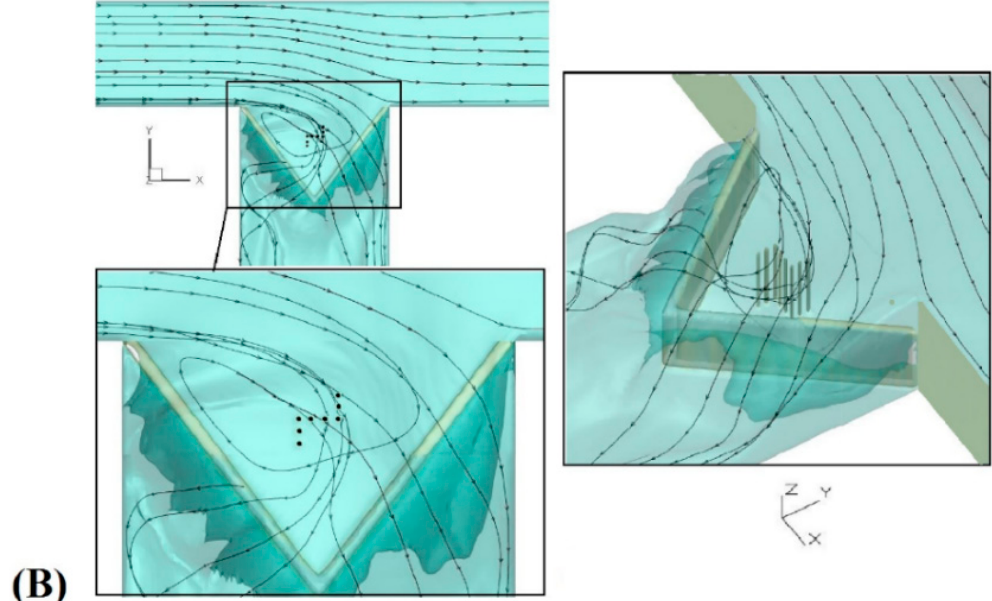
Figure 9. Schematic of streamlines and vortexes formed inside the triangular labyrinth side weir, ( A ) without an antivortex and ( B ) with an antivortex.